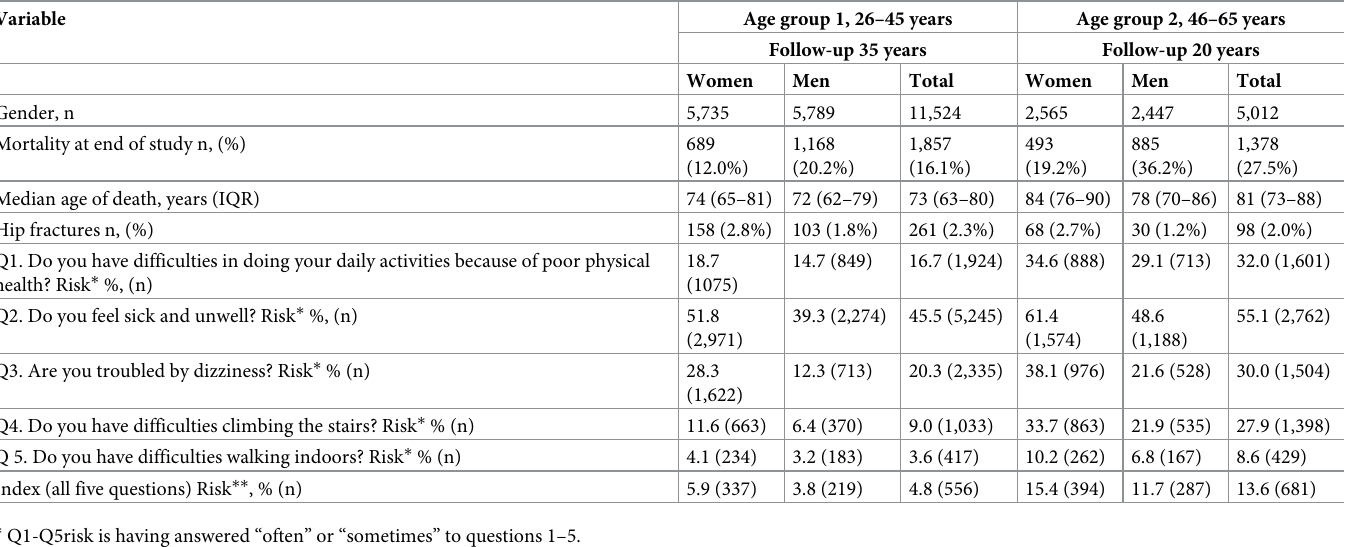
Table 1. Baseline characteristics for our sample of the REBUS cohort